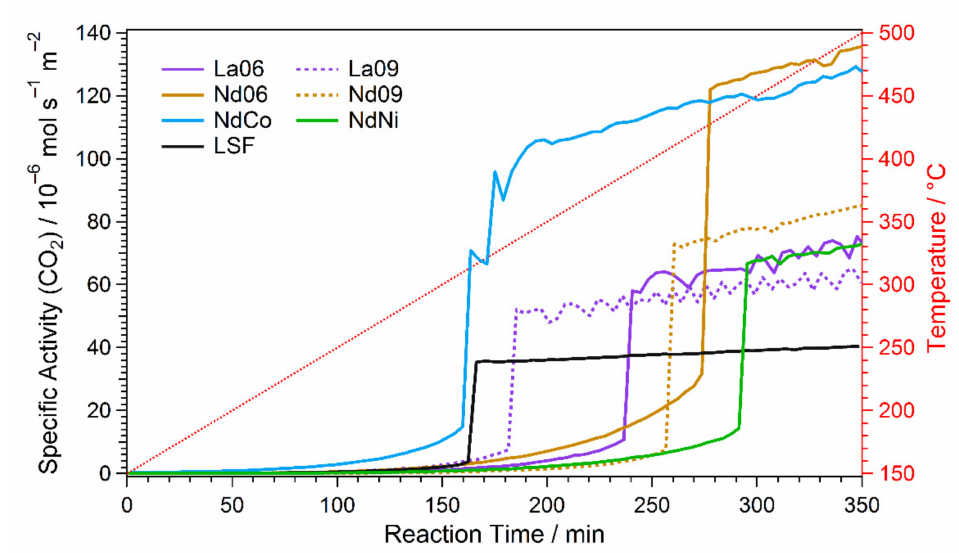
Figure 2. Comparison of CO oxidation results during heating experiments. The specific activities of the respective perovskites are shown. LSF was added as reference (full black line); the temperature progression during the catalytic test is displayed on the second y-axis. To perform the catalytic tests, a 2:1 mixture of CO and O 2 was used for stoichiometric reasons (4 mL min − 1 and 2 mL min − 1 , respectively). The temperature was increased from 150 to 500 ◦ C at a rate of 1 ◦ C min − 1 . The highest activities were found for the B-site undoped sample Nd06 and the Co-doped perovskite NdCo. LSF performed worse than all investigated